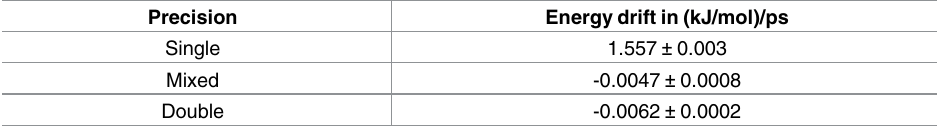
Table 5. Energy drift for different precision models for the DHFR explicit solvent system. Precision Single Double The reported uncertainty in each value is the standard error of the drift rates from ten independent simulations.